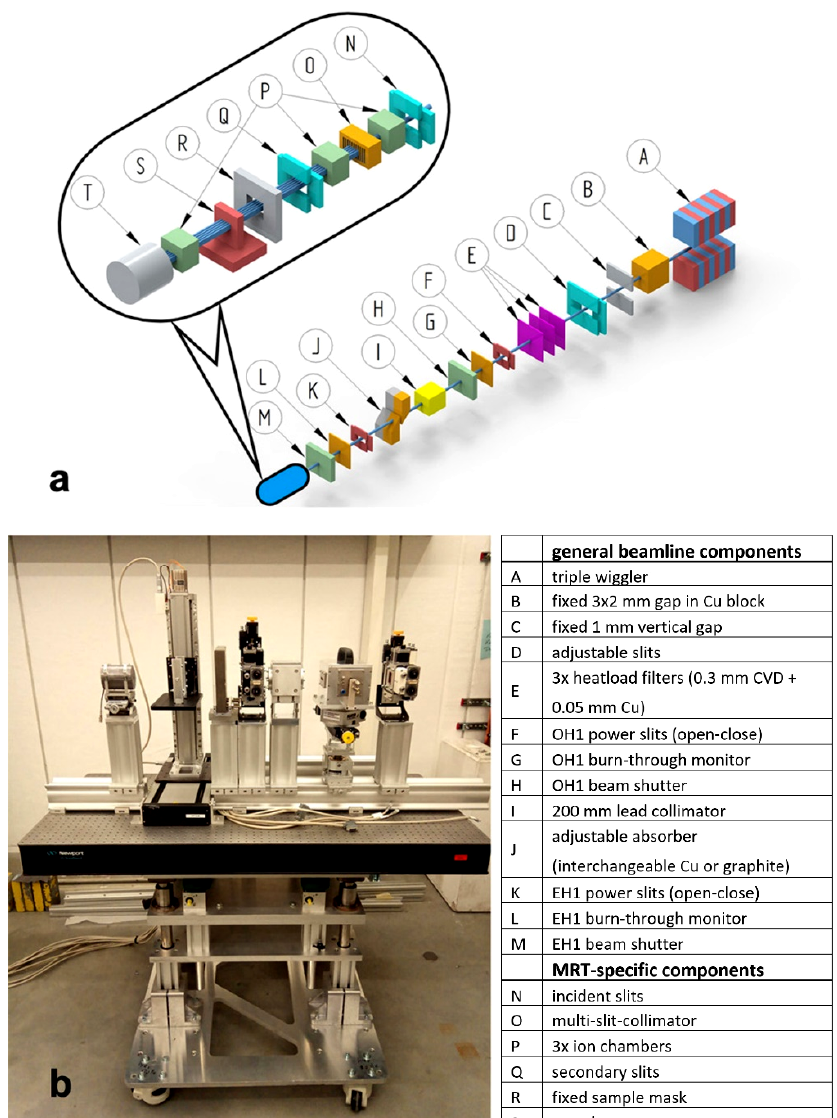
Figure 1. Design of Beamline P61A. Schematic of the beamline ( a ), the parts for the mobile insert for biomedical work are depicted as N-T and the insert that is located at a distance of 108 m from the last wiggler source is shown in the photograph ( b ).